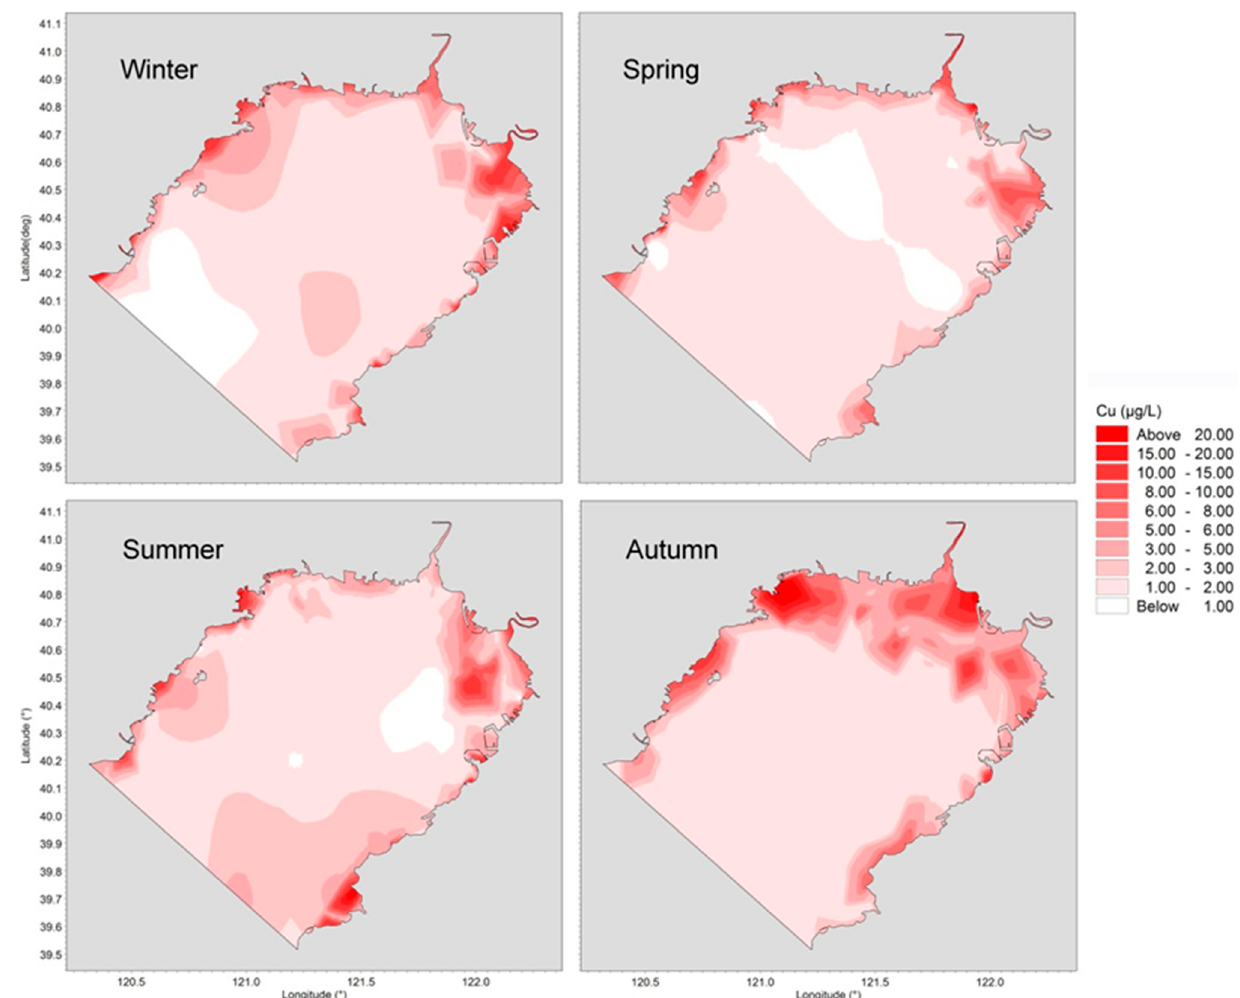
Figure 4. Horizontal distributions of dissolved Cu in Liaodong Bay from February 2020 to October 2020.